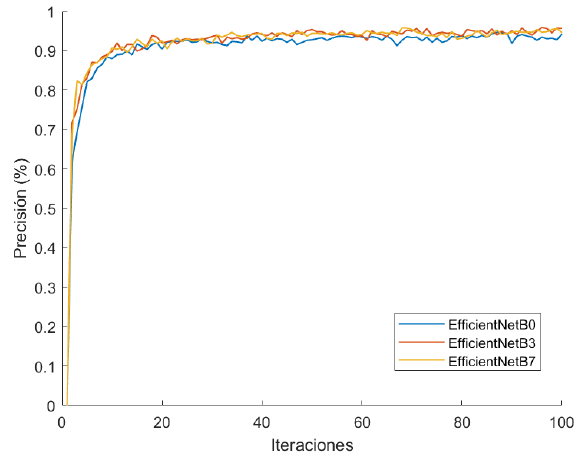
Figure 16. EfficientNet B0-B3-B7 comparison in Stanford-Cars training.